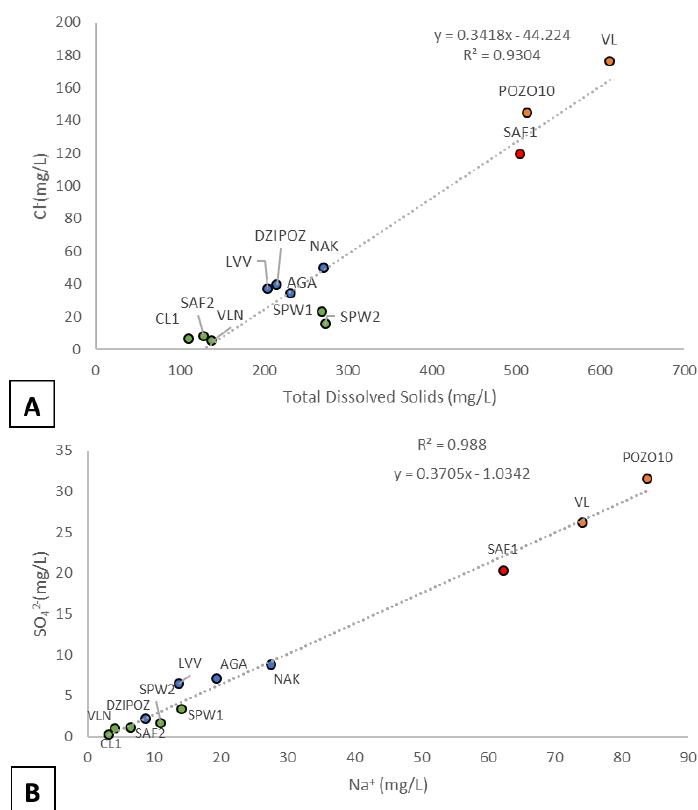
Figure 4. Total dissolved solids / chloride lot and sulfate / sodium plot. ( A ) Chloride / total dissolved solids; ( B ) sodium / sulfate.